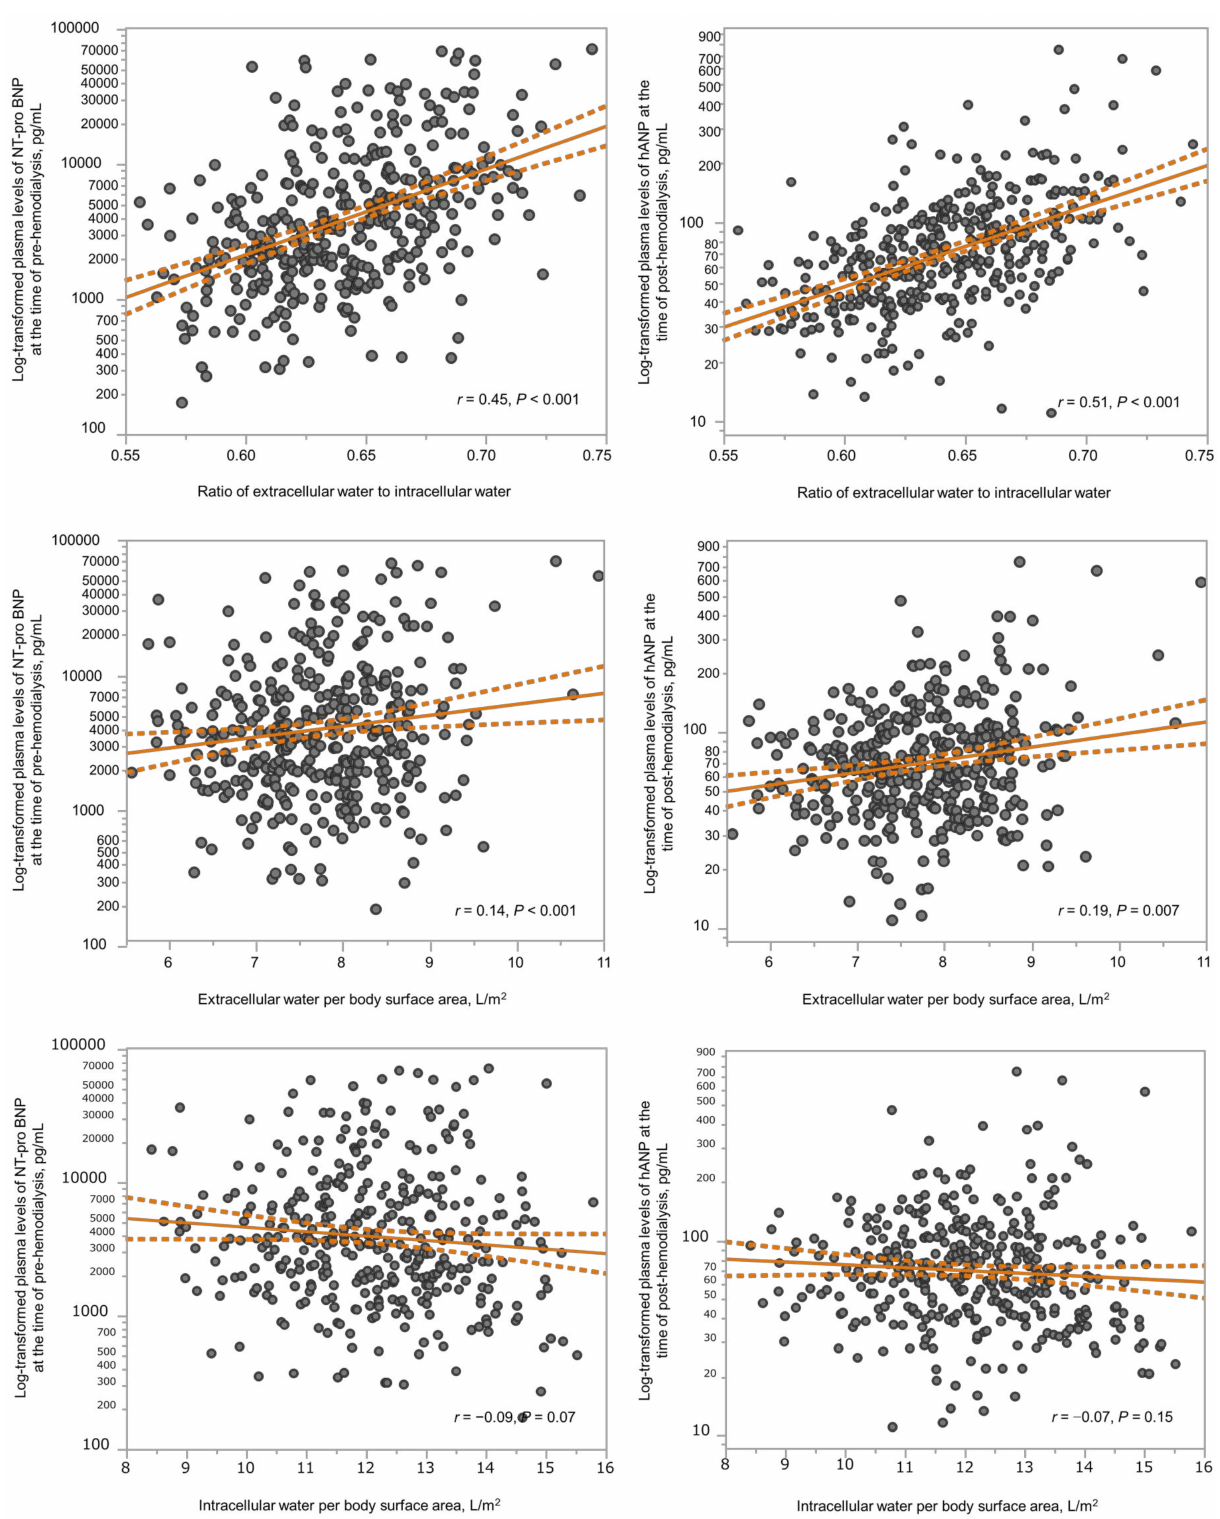
Figure 2. Scatter plots showing the correlations between the ECW/ICW ratio (upper X axes), the ECW per BSA (middle X axes), or the ICW per BSA (below X axes) and the log 10 -transformed natriuretic peptides (y axes). Solid lines and dashed lines show regression line and confidence interval, respectively. ECW, extracellular water; ICW, intracellular water; NT-proBNP, pre-dialysis N -terminal pro-B-type natriuretic peptide; hANP, post-dialysis human atrial natriuretic